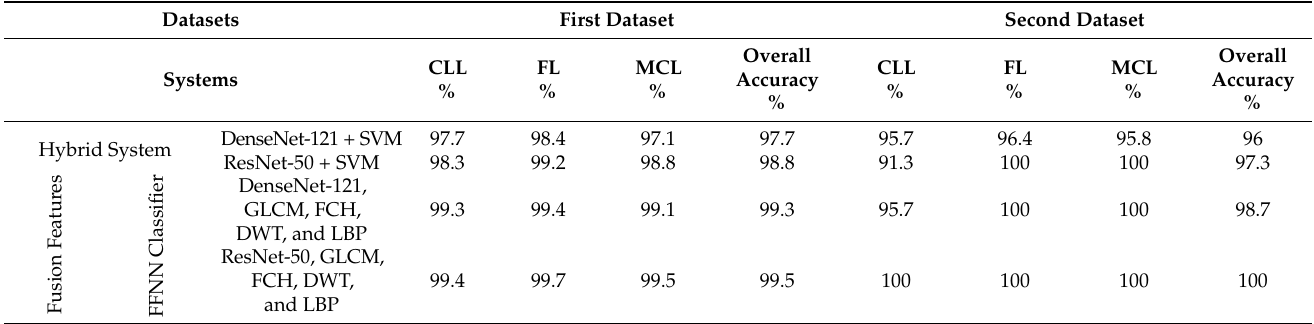
Table 5. The results of the proposed systems in the diagnosis of the types of malignant lymphomas. Datasets